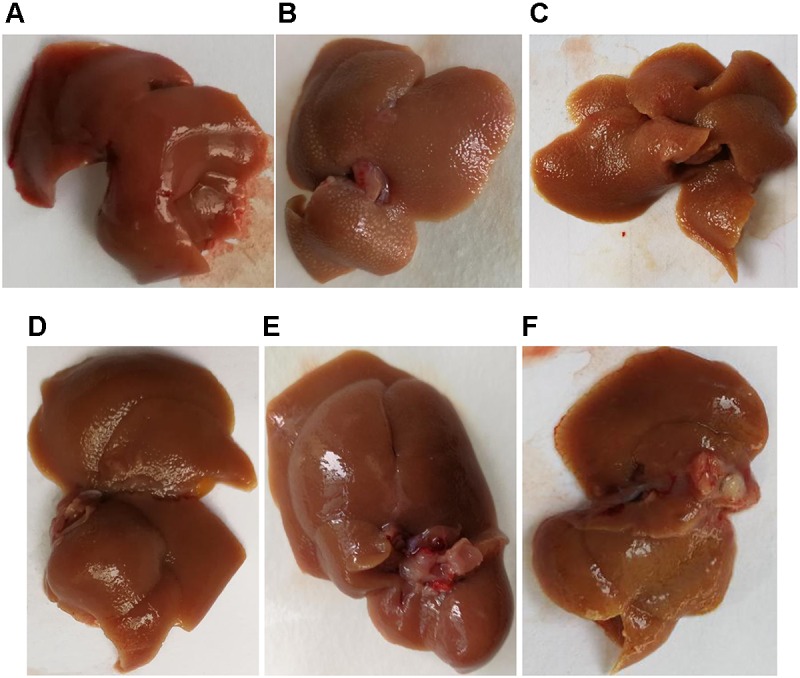
Liver morphology of different group, (A) blank control group, (B) CCl4-induced liver fibrosis group, (C) PHD1shNC group, (D) PHD1shRNA group, (E) PHD1+Keap1shRNAs-transfected prevention group, and (F) therapeutic group.